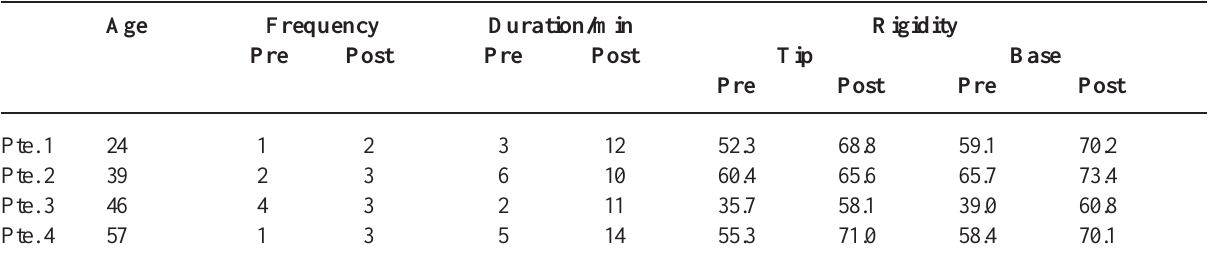
Table 1 – Results of RigiScan nocturnal tumescence monitoring. The erectile episodes rate during 3 nights of registration (frequency), the duration of the best erectile episode (duration/min.) and the base and tip rigidity percentage of the best erectile episode, before (pre) and after (post)